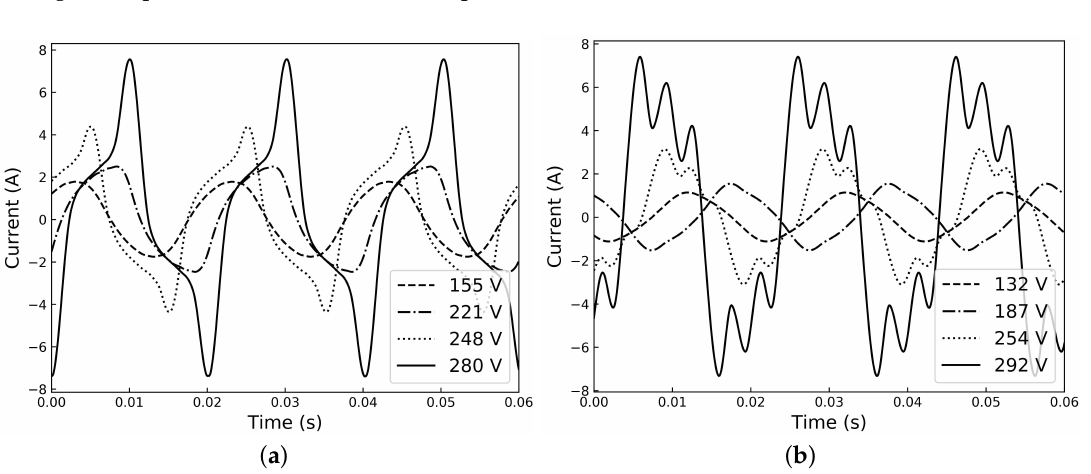
Figure 3. The measured current of the three-phase transformer under different excitation voltages with ( a ) B-phase excitation and ( b ) three-phase